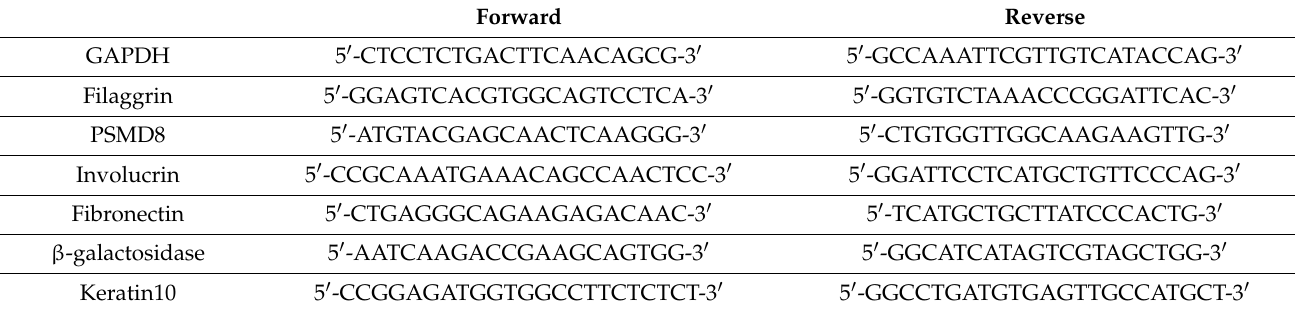
Table 1. List of primer sequences used for